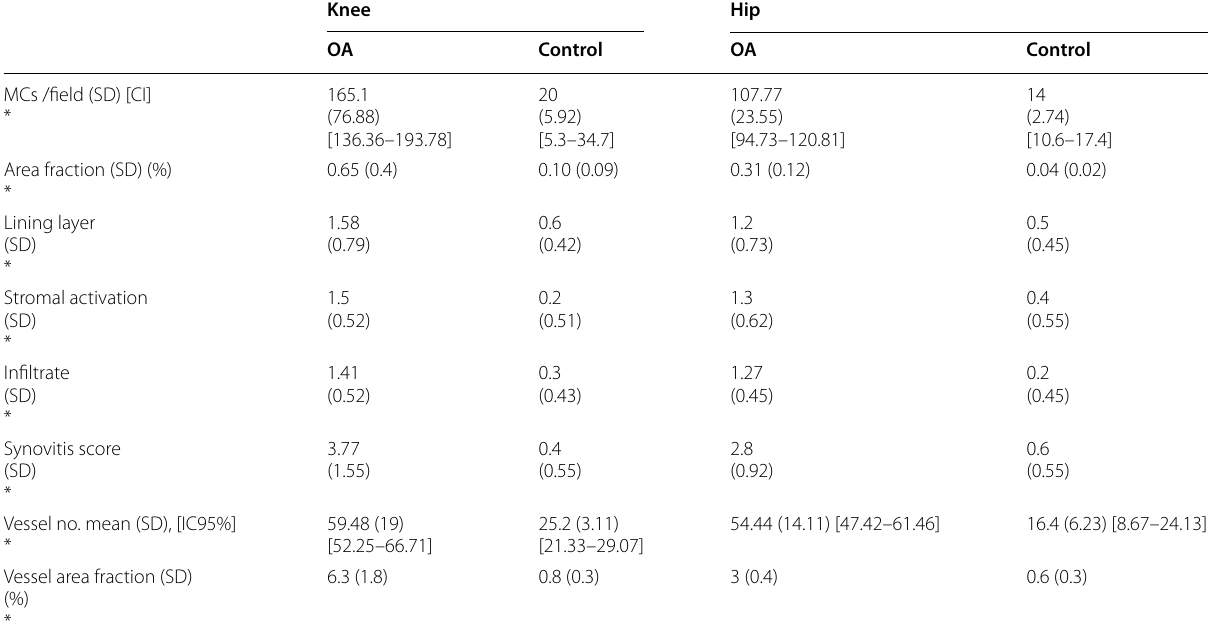
Table 3 Evaluation of the mast cell (MC) infiltrate and Synovitis score in the 60 osteoarthritis (OA) patients. SD: standard deviation; * significant differences with p < 0.05 in Knee and Hip